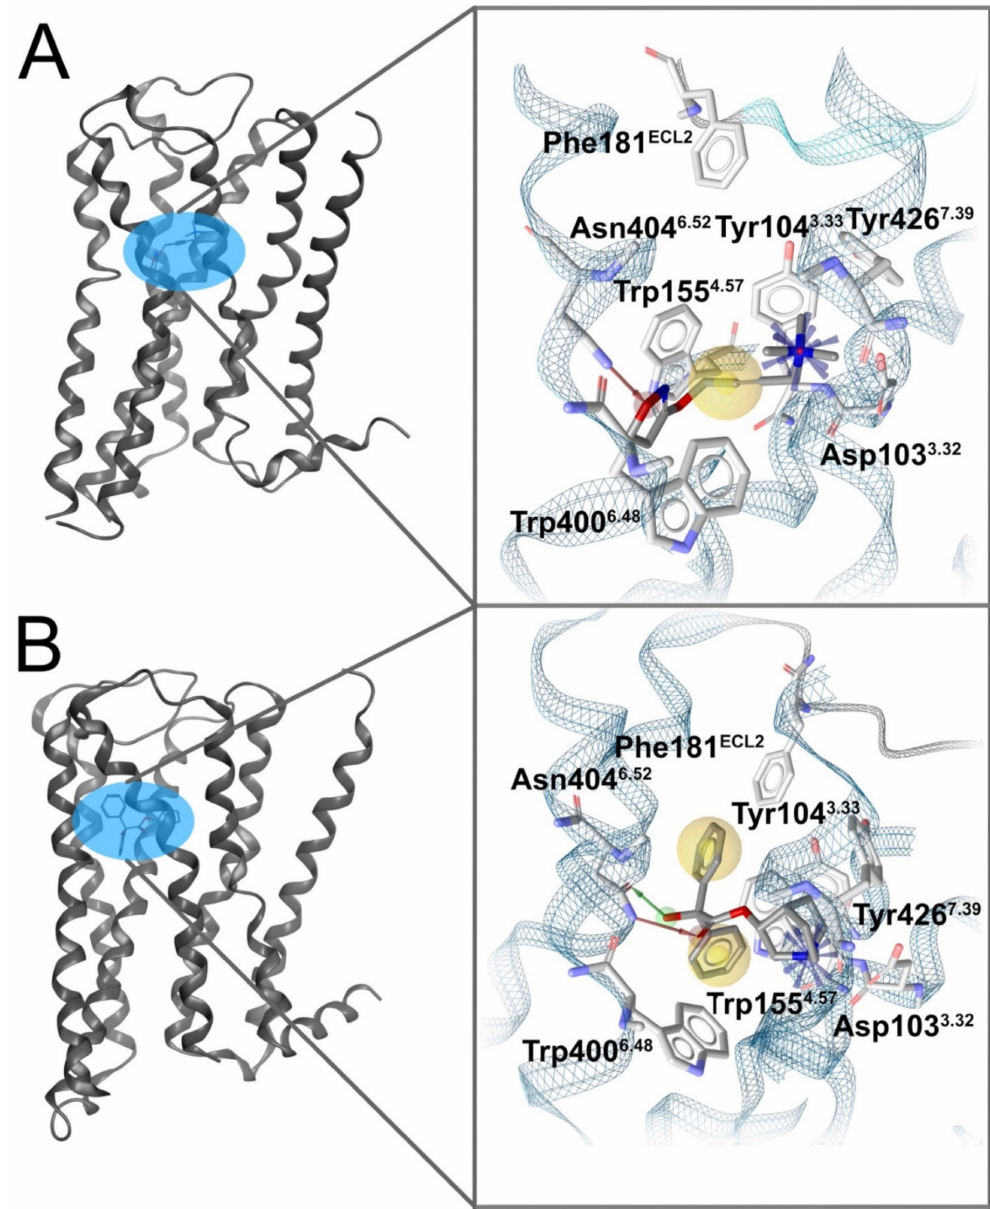
Figure 1. M2 muscarinic acetylcholine receptor in an ( A ) active-like conformation bound to orthosteric agonist iperoxo (adapted from PDB code 4MQS [11]) and ( B ) an inactive-like conformation bound to an orthosteric antagonist (adapted from PDB code 3UON [12]). Yellow spheres = hydrophobic contacts, blue bursts = positive ionizable areas, red arrows = hydrogen bond acceptor positions, green ar- rows = hydrogen bond donor positions. Binding site conformation representations were created using LigandScout v. 4.4.3 (Inte: ligand, Vienna, Austria) [13]. Residue numbers in superscript follow the Ballesteros–Weinstein numbering system for the conformational numbering of class A GPCR residues